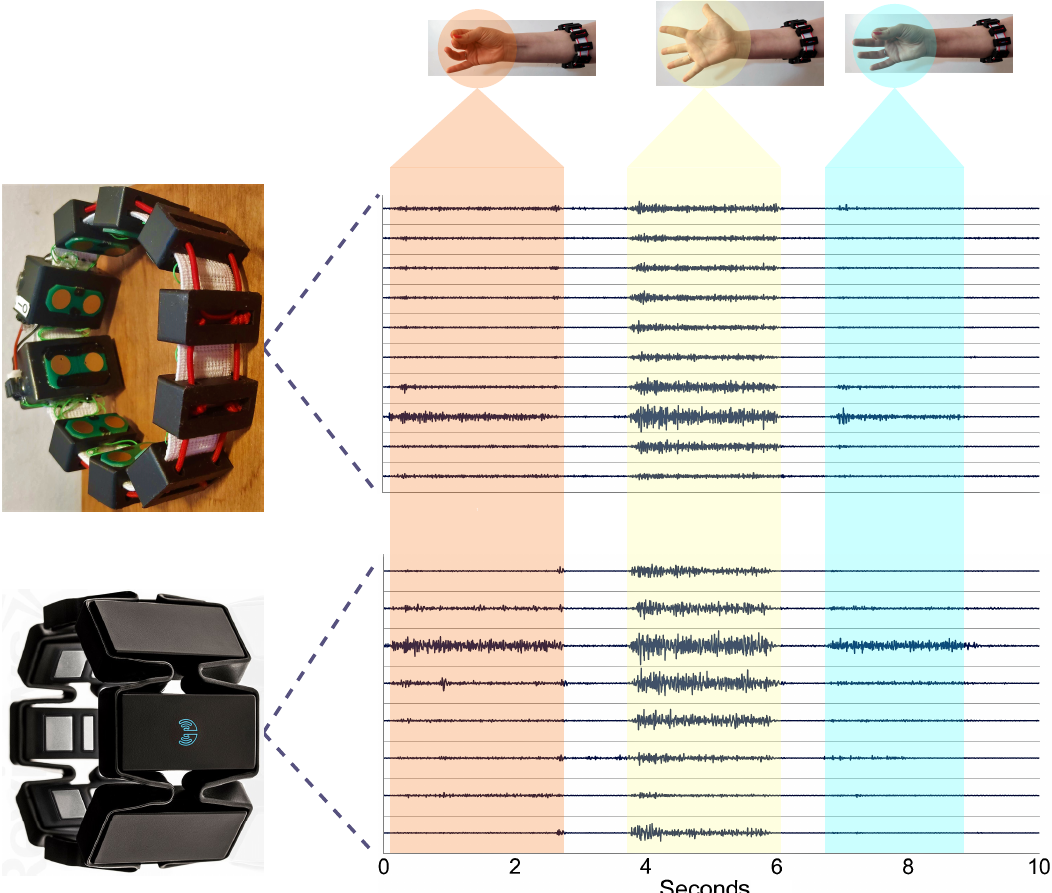
Figure 8. Comparison of the signals recorded with the Myo Armband and the proposed 3DC Armband. The x -axis represents time in seconds, while the y -axis is the different channels of the armbands. The three gestures recorded in order are the chuck grip , Open Hand , and Pinch Grip . Note that these signals were not obtained using the Comparison Dataset recording protocol to show a wider array of gestures in a continuous